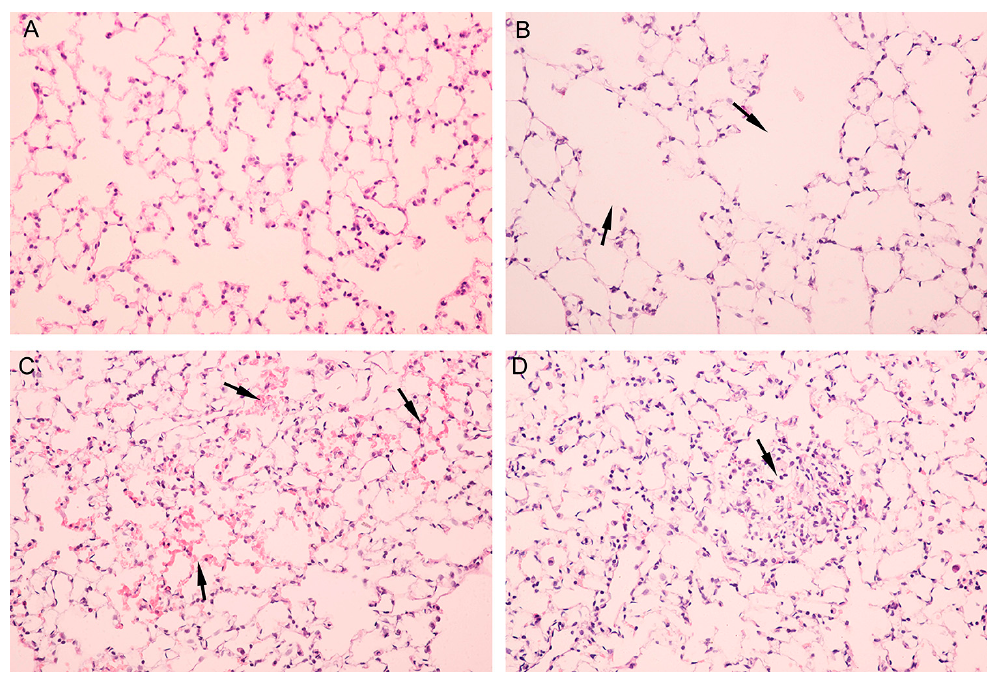
Figure 3. Pathology of mice lung tissues following Al 2 O 3 treatment. ( A ): control; ( B ): arrows showed ruptured alveolar walls and fusion of pulmonary alveoli; ( C ): arrows showed pneumorrhagia in lung tissues; ( D ): arrows demonstrated lymphocyte infiltration in lung tissues.